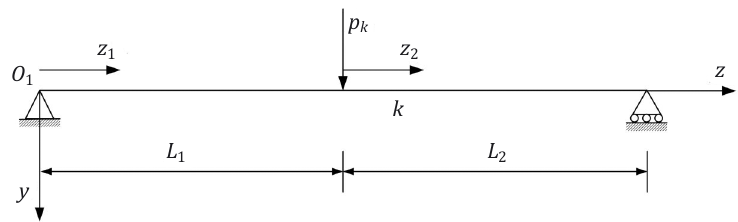
Figure 3. The coordinate and load system of a CW-SBS box